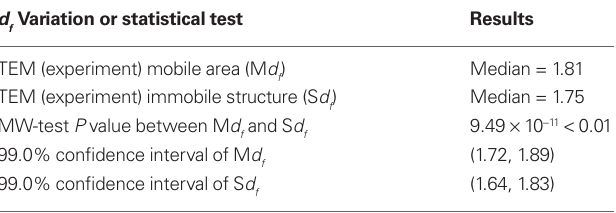
Table 3 | Statistical analysis of two intracellular d